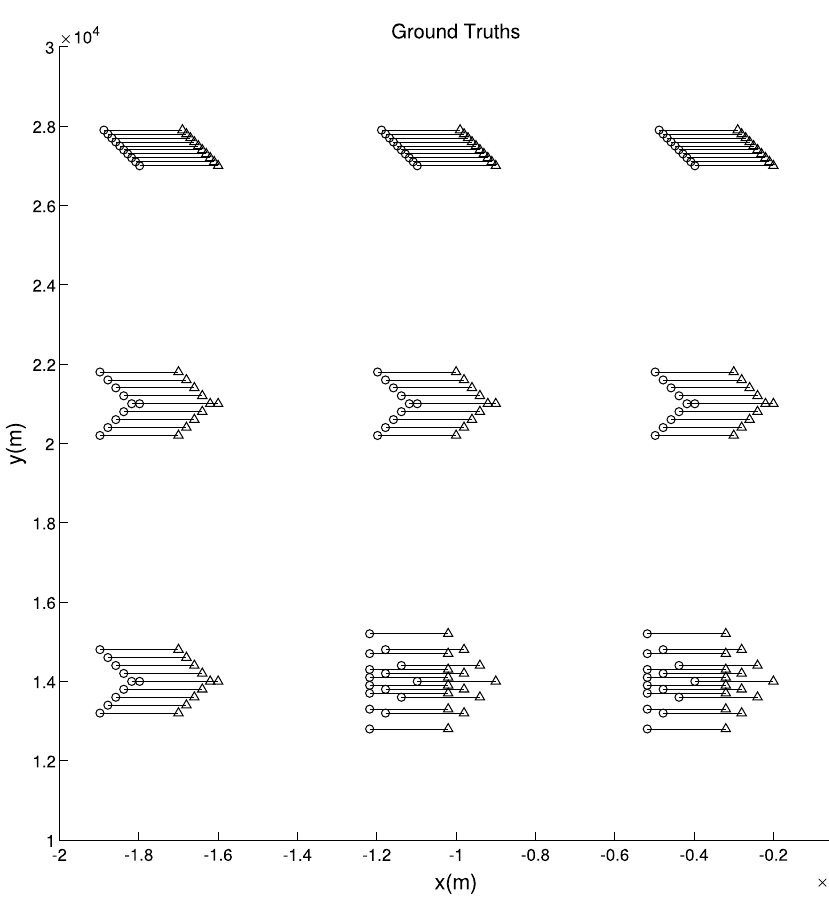
Fig. 8 True trajectories of all